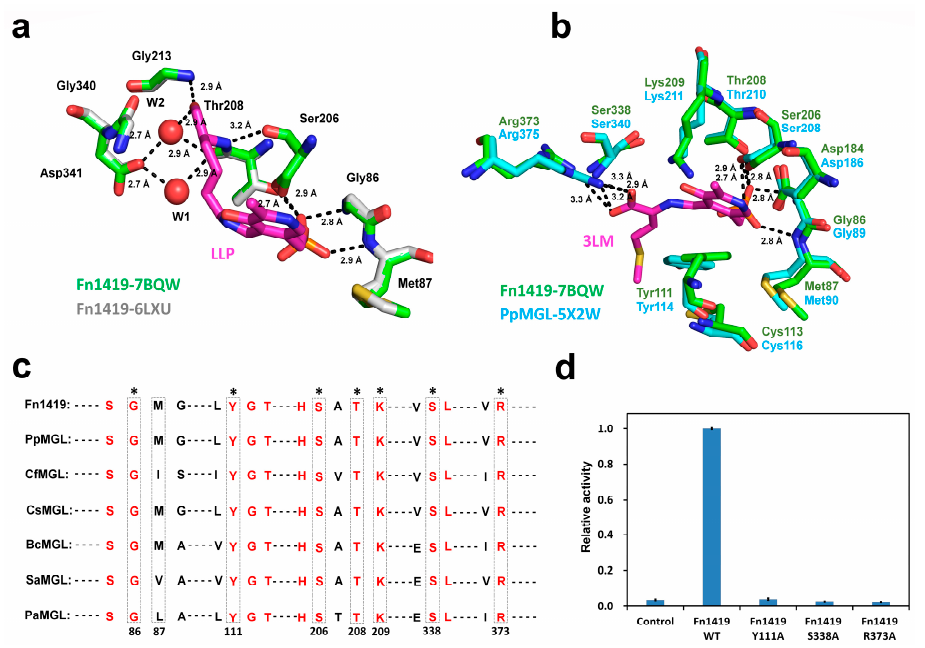
Figure 3. Analysis of PLP- and substrate-binding sites on Fn1419. ( a ) Superimposition of the active sites of PLP-free (PDB code: 7BQW) and PLP-bound (6LXU) states of Fn1419. ( b ) Superimposition of the active sites of Fn1419 and PpMGL-Met (5X2W). ( c ) Partial sequence alignment of MGL enzymes from seven bacteria [ Pseudomonas putida (Uniprot accession no. P13254), Citrobacter freundii (Q84AR1), Clostridium sporogenes (A0A1J1CYV7), Bacillus cereus (Q818A3), Staphylococcus aureus (SAV0460), and P. aeruginosa (A0A2R3IX25)]. The PLP-binding residues are indicated by dotted boxes, and conserved residues for PLP binding are indicated by asterisks. All conserved residues shown in red. The numbering refers to Fn1419. ( d ) Measurement of the Fn1419 activity with Fn1419 mutants (Y111A, S338A, and R373A). The error bars represent the standard deviation of three replicates.